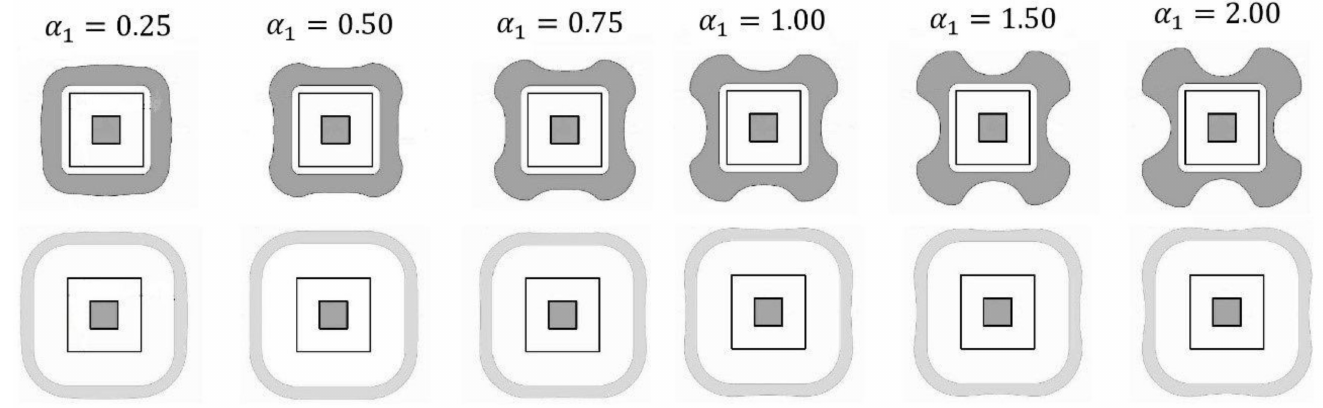
Figure A1. Graphs of the shear forces in the control perimeter depending on the shear cap height—80 cm shear cap width (c/d = 4).